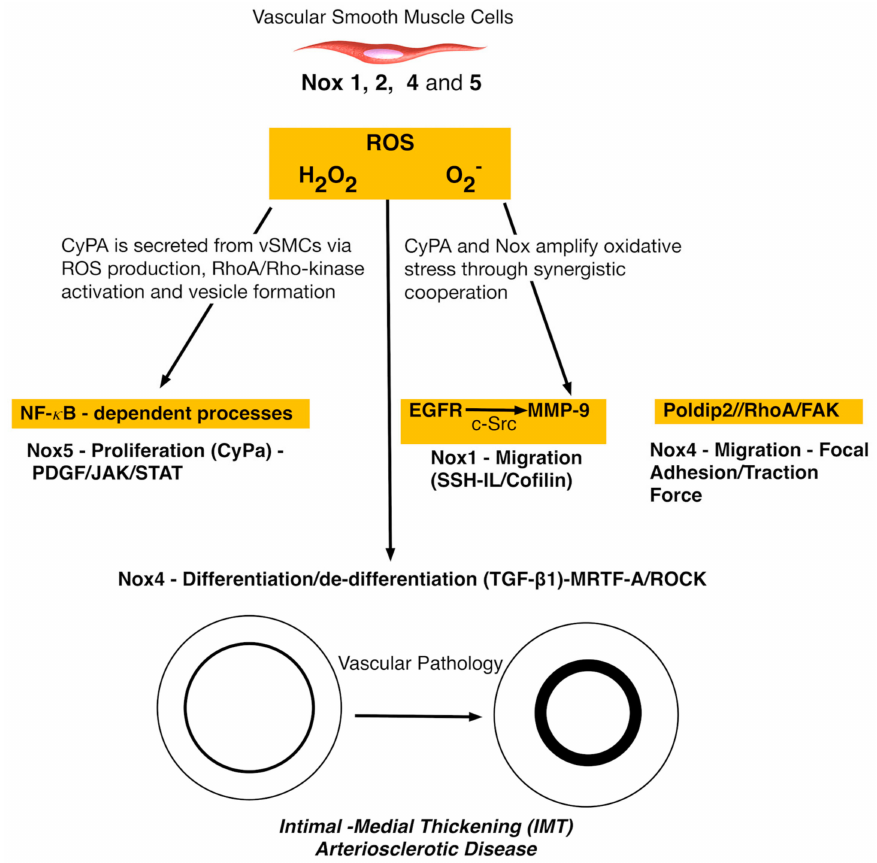
Figure 3. Simplified schematic of common forms of Nox enzymes in vascular smooth muscle cell (vSMCs). Nox4, once activated, generates H 2 O 2 . Nox1 expression is increased early and decreased with lesion progression, while induction of Nox4 is a late event. Nox2 and p22phox are elevated throughout lesion development. SMCs have increased generation of ROS, cell cycle arrest, evidence of senescence, and increased susceptibility to apoptosis